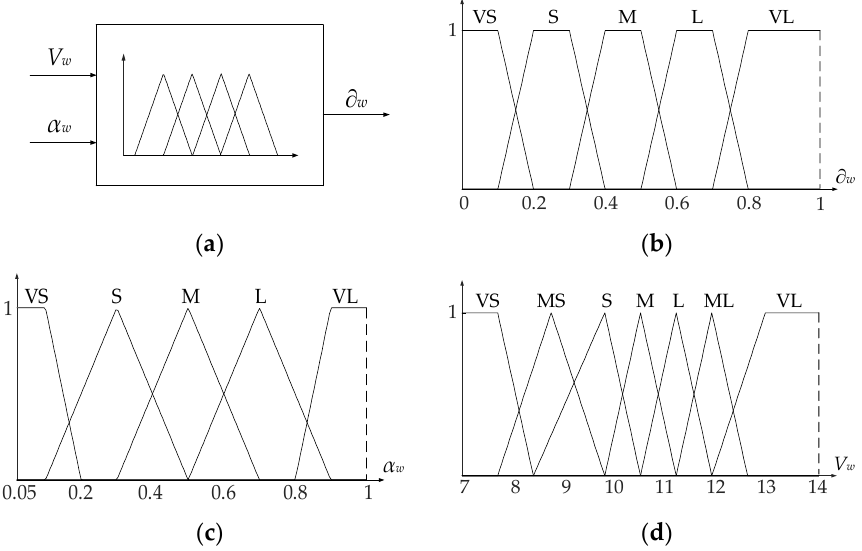
Figure 8. The structure diagram and membership of FLC-2. ( a ) The structure diagram of FLC-2, ( b ) the membership function of ∂ w , ( c ) the membership function of α w , and ( d ) the membership function of V w .